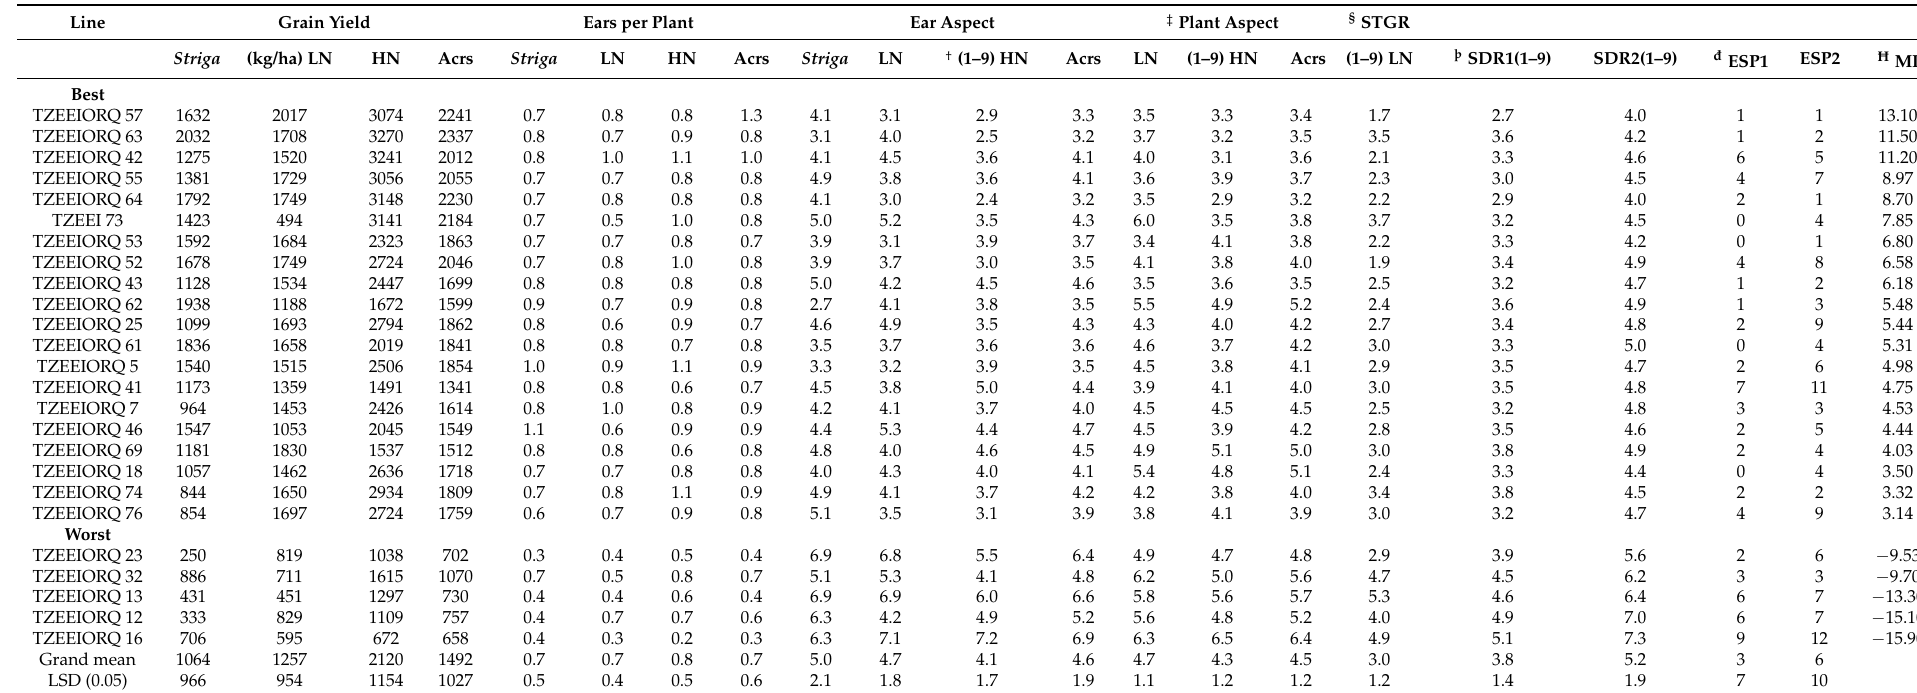
Table 6. Grain yield and other agronomic traits of 20 best and 5 worst extra-early maturing provitamin A quality protein maize inbreds evaluated under Striga -infested, low-N and high-N environments.